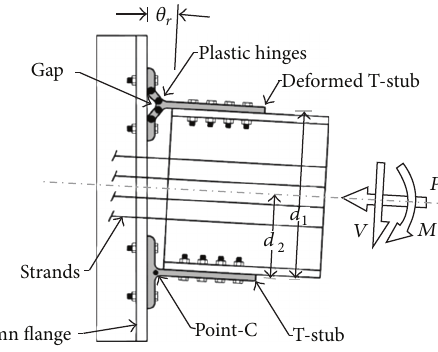
Figure 5: Deformation of PTTC under applied